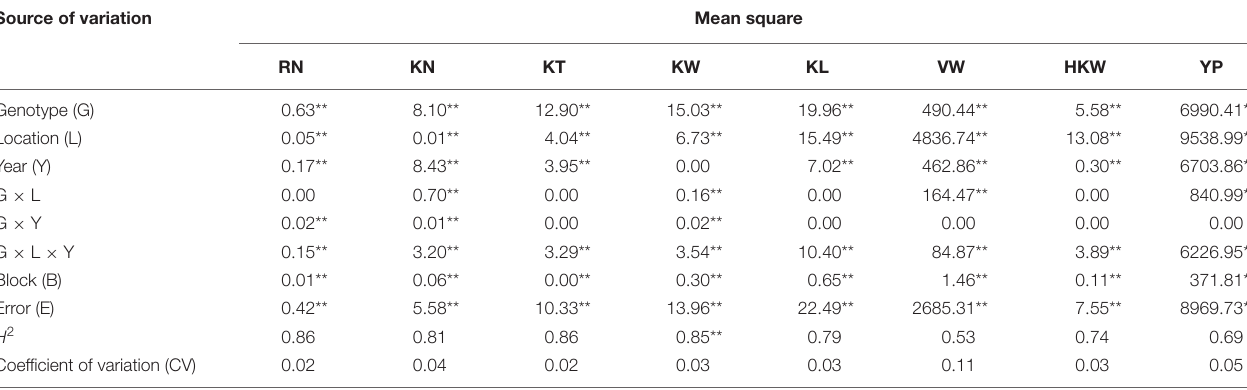
TABLE 2 | Combined analyses of variance for eight yield-related traits in Ye478 × Qi319 RILs. Source of variation Mean square